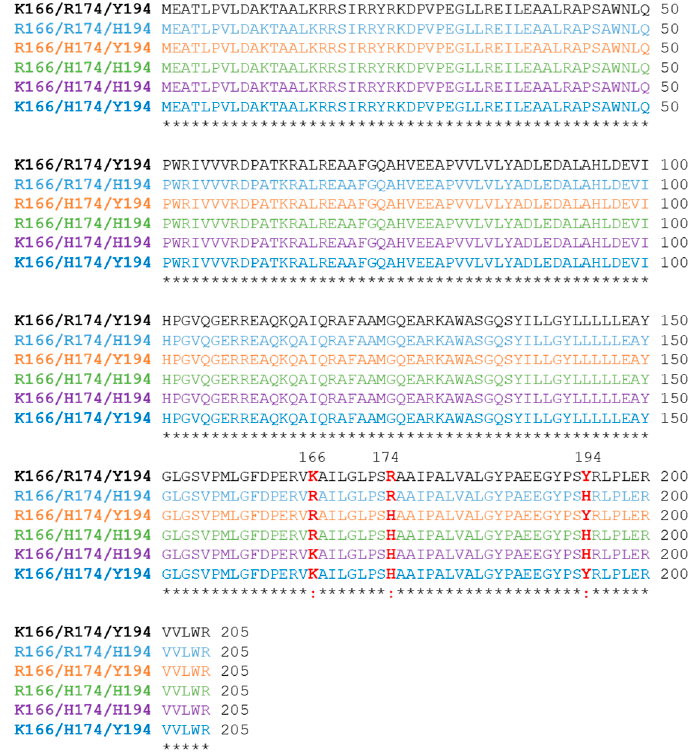
Figure 1. Sequence alignment of the different constructed variants of NOX. Sequence alignment was performed using the ClustalW algorithm. (*) Identical residues; (:) different residues, highlighted in red. K166/H174/Y194 variant sequence resulted from cloning and sequencing of PCR product amplified from genomic DNA of T. thermophilus HB27 that we have at our laboratory. K166/H174/H194 variant: the sequence of the variant as it appears in Kyoto Encyclopedia of Genes and Genomes (KEGG, available online: http://www.genome.jp/kegg/kegg2.html). R164/R174/H194 variant sequence corresponds to gene bank accession number CAA42707.1, 1NOX pdb code (doi: 10.2210/pdb1nox/pdb) and it is the variant from T. thermophilus HB8 described by Park et al. [3]. R166/H174/H194 variant sequence corresponds to the sequence as it appears in the BacMap genome atlas (Available online: http://wishart.biology.ualberta.ca/BacMap/). K166/R174/Y194 and R166/H174/Y194 variants correspond to the other two mutants studied in this work.